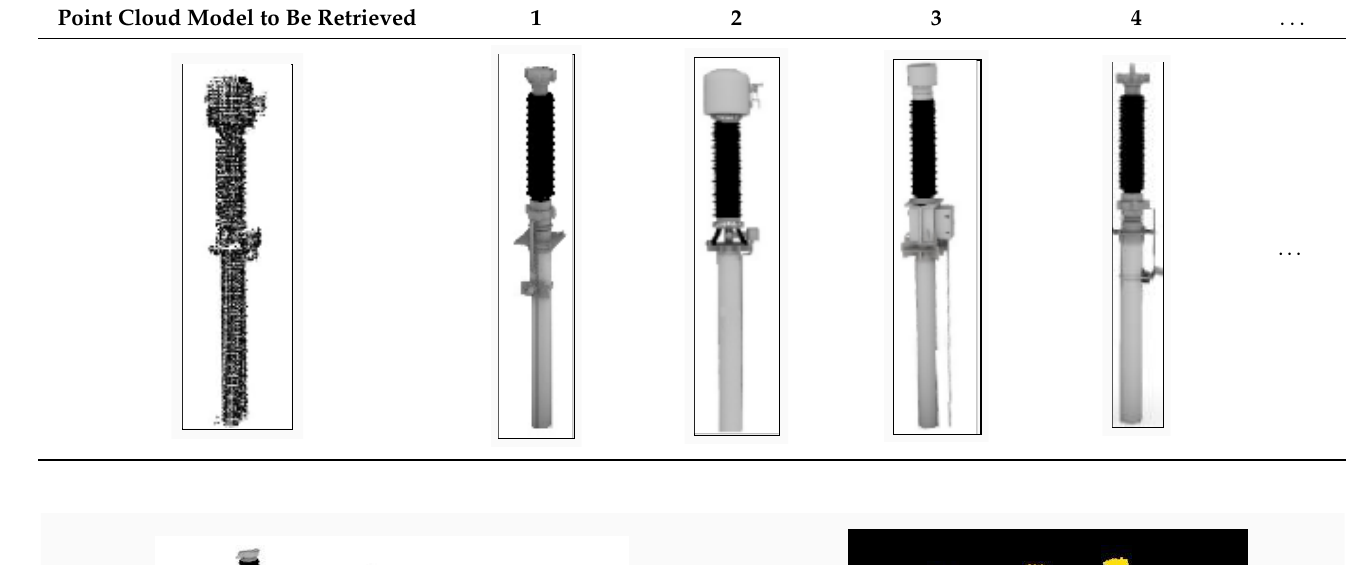
Table 2. Results of the model screening by the OBB bounding box.